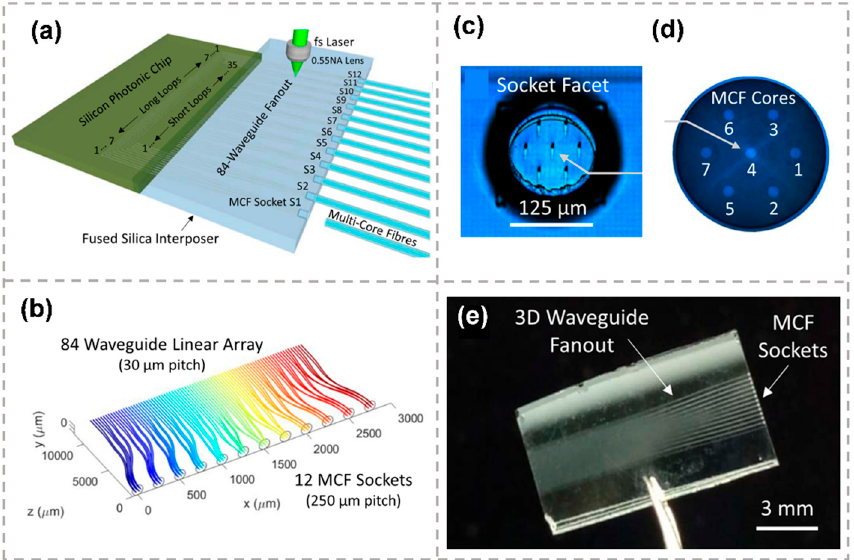
Figure 12. ( a ) A femtosecond (fs) laser inscribes an optical waveguide fanout together with etching tracks that open into MCF alignment sockets after chemical etching. ( b ) Schematic for the waveguide routing design, fanning out from a linear array ( SiP chip at back) to 12 socket positions for MCF packaging. ( c ) End view of a MCF socket, showing precisely positioned waveguides on the buried facet. ( d ) Image of a cleaved MCF facet showing hexagonal arrangement of the seven core waveguides and their labels. ( e ) Photo of the fabricated fused silica fan-out device [129]. Reproduced from [129] with permission of the IOP Publishing, 2022.